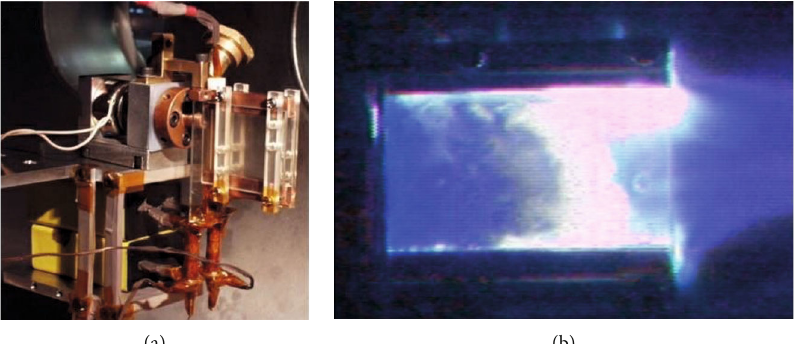
Figure 6: LP-PPT of Tokyo University: (a) picture of a parallel plate LP-PPT; (b) streak photograph of parallel plate LP-PPT fi ring [22].